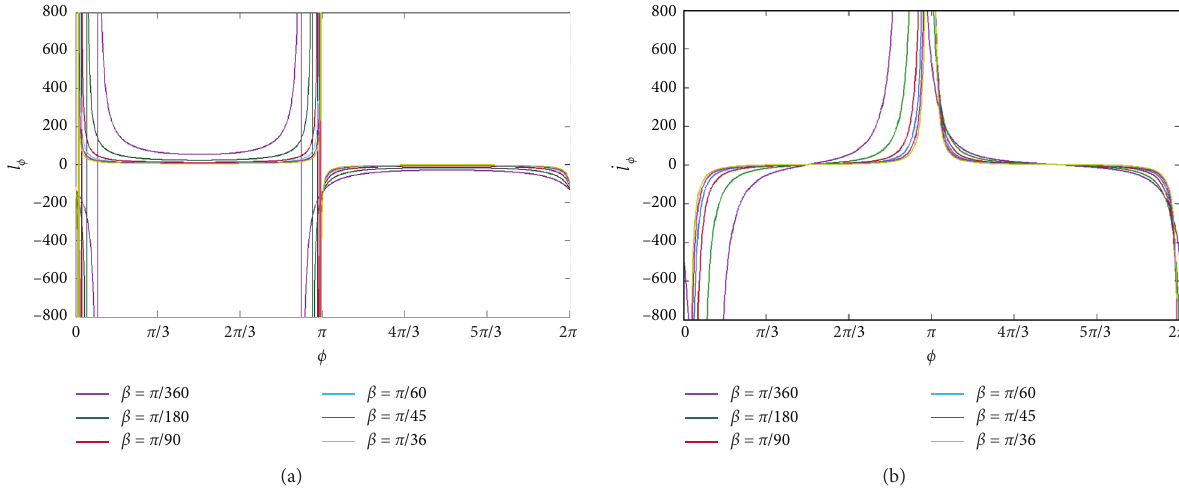
Figure 4: The relationship between the length of the gravity block l well inclination angles β .